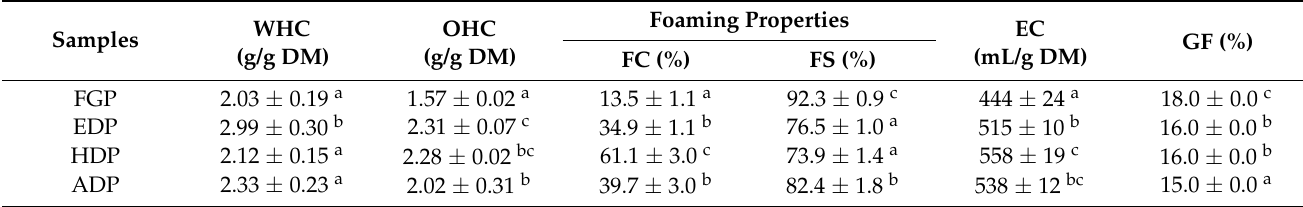
Table 2. Techno-functional properties of G. bimaculatus and three defatted protein concentrates.